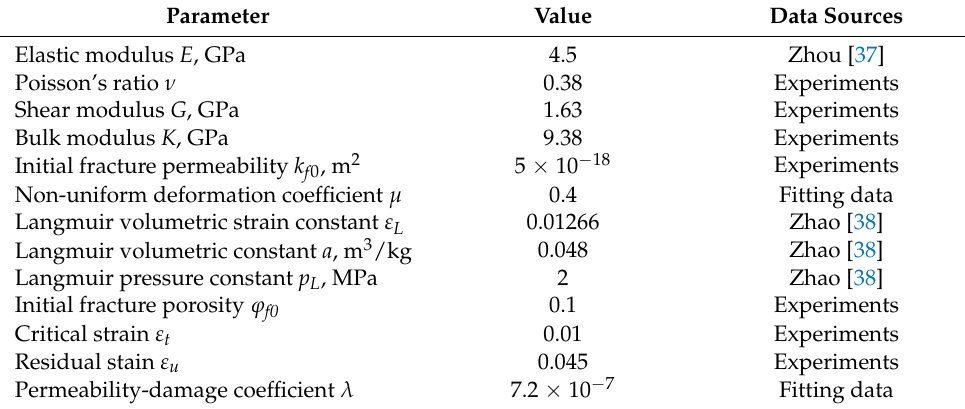
Table 1. Basic parameters for numerical